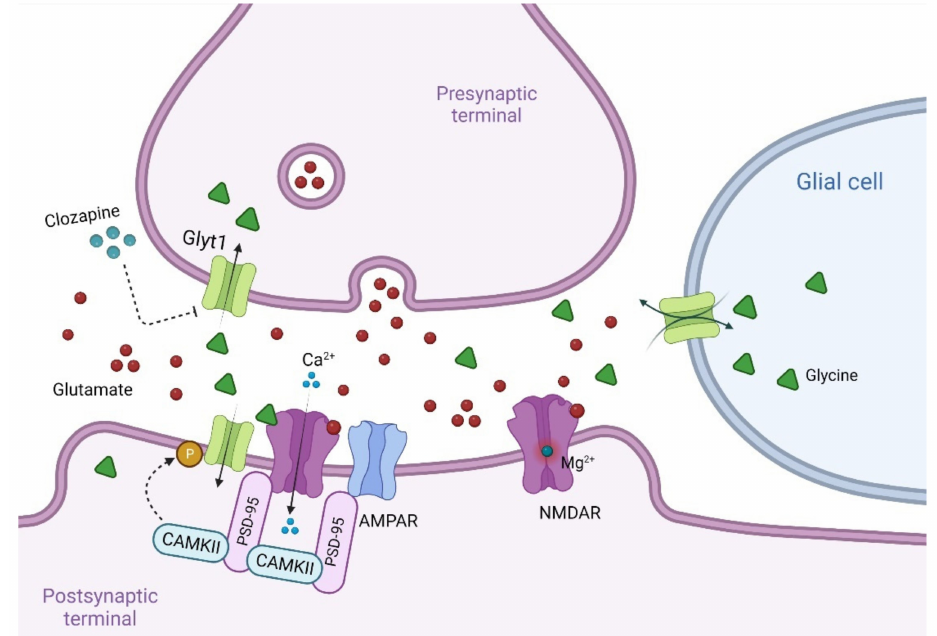
Figure 4. Glycine transporter 1 (GlyT1) controls glycine concentration in the synaptic cleft. GlyT1 is localized at the postsynaptic density of glutamatergic synapses and may physically interact with NMDAR complex. GlyT1 activity is regulated by indirect phosphorylation by CaMKII. It has been proposed that clozapine may exert its antipsychotic activity, among other mechanisms, by inhibiting GlyT1. GlyT1: Glycine Receptor Transporter 1; NMDAR: N-Methyl-D-aspartate receptors; PSD-95: postsynaptic density protein 95; CaMKII: Ca2+/calmodulin-dependent protein kinase; AMPAR: α - amino-3-hydroxy-5-methyl-4-isoxazolepropionic acid receptor; PSD-95: postsynaptic density protein 95. Mg 2+ : magnesium. Created with BioRender.com (accessed on 14 June